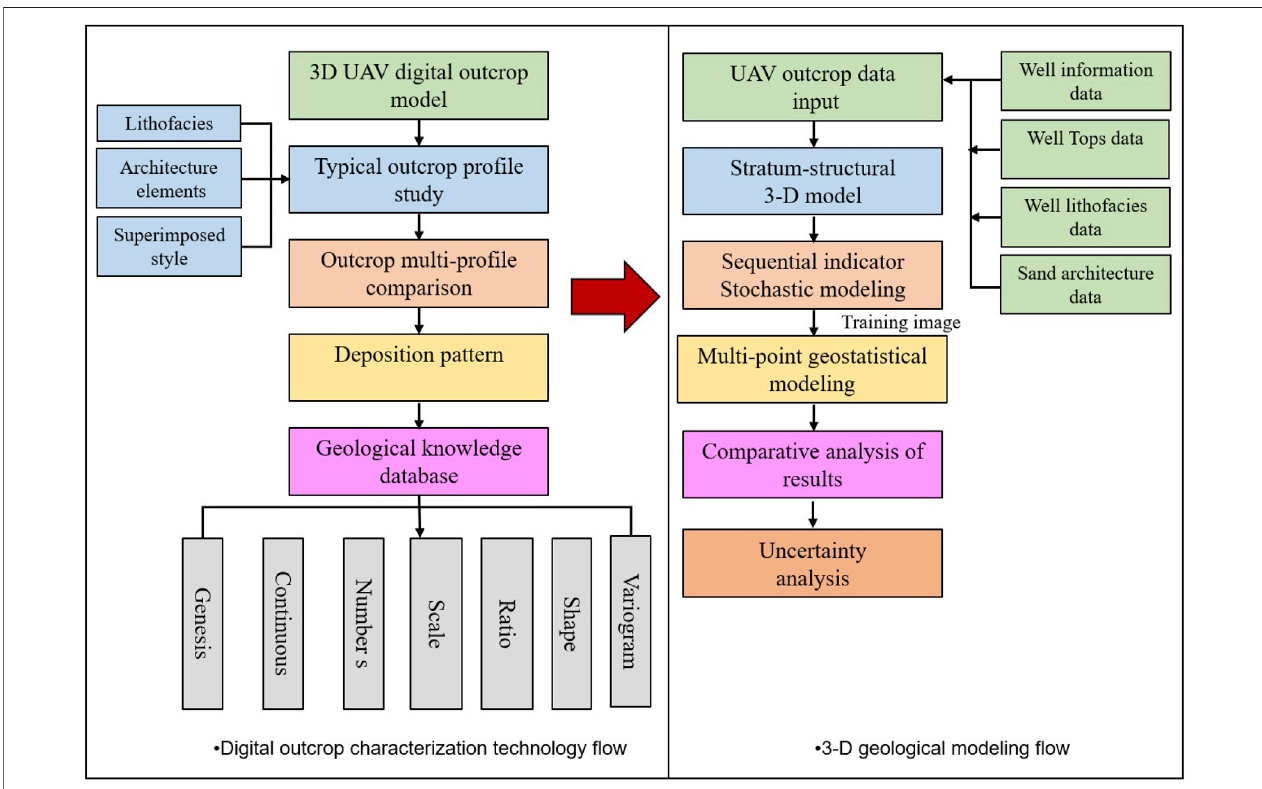
FIGURE 3 | Digital outcrop characterization technology and 3-D geological modeling fl ow